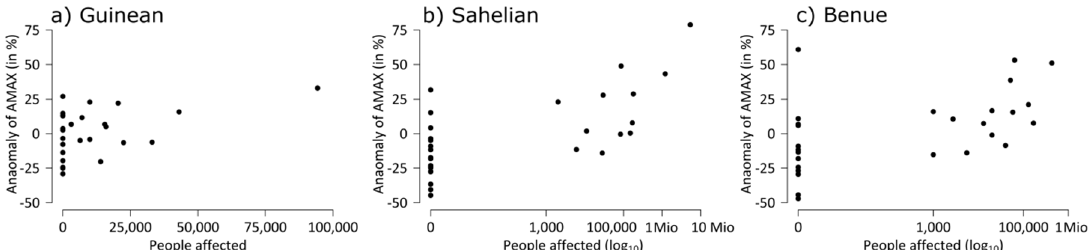
Figure 8. People affected by catastrophic floods per year in the Niger River Basin from 1980 to 2014 for three different data sources. Note that the scale of the y-axis is logarithmic.